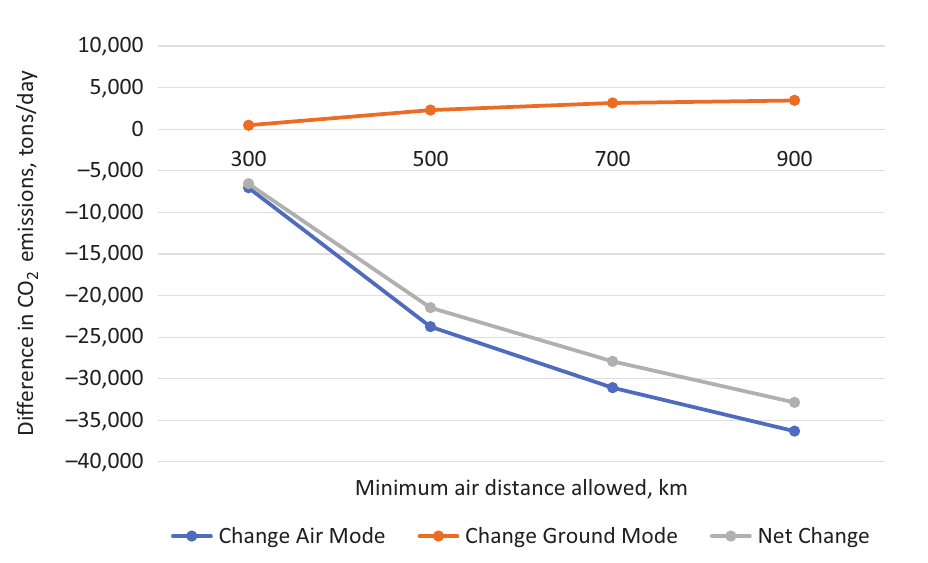
Figure 3. Change in CO emissions due to minimum distance restriction for air 2